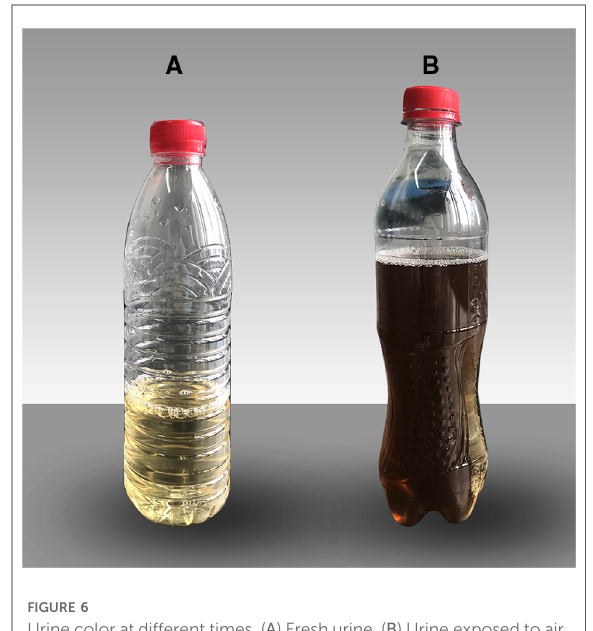
FIGURE 6 Urine color at different times. ( A ) Fresh urine. ( B ) Urine exposed to air for 24